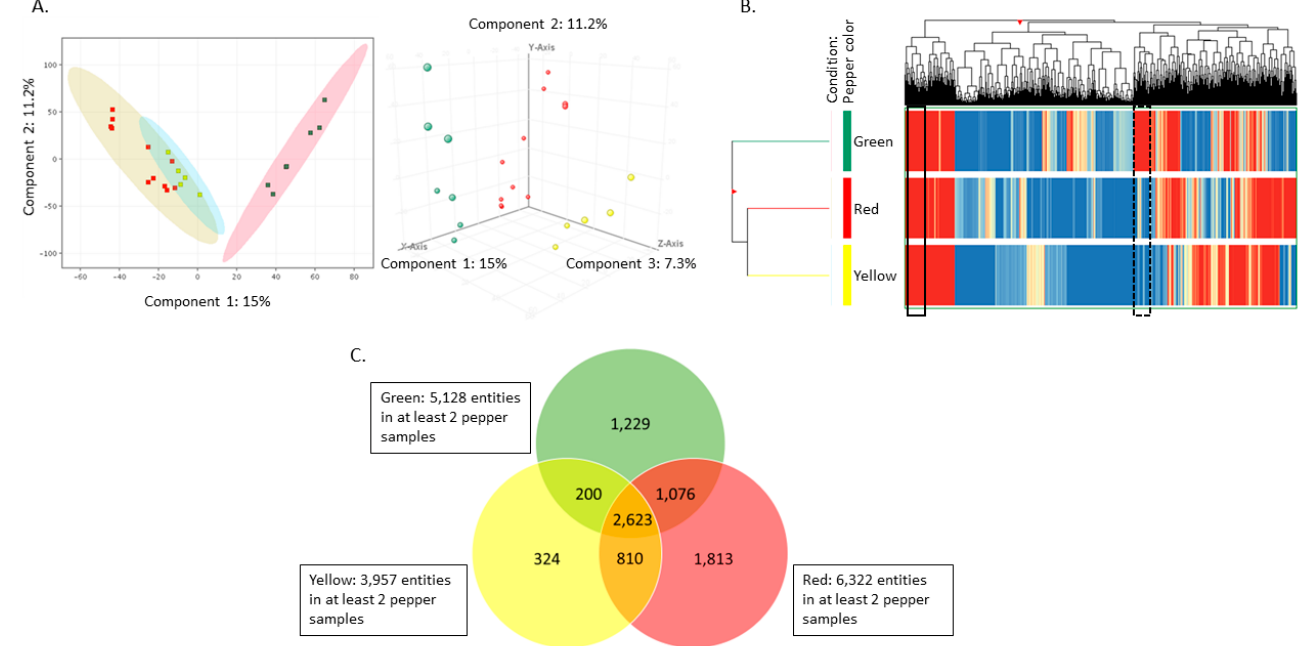
Figure 1. Pepper color is the main driver of differences between pepper conditions. ( A ) Principal component analysis (PCA) was performed in Agilent Technologies Mass Profiler Professional Version 14.1 (MPP) using data from all bell pepper samples. Component 1, which explains 15% of the variation, is shown on the x -axis; component 2, which explains 11.2% of the variation, is shown on the y -axis; and component 3, which explains 7.3% of the variation, is shown on the z -axis. ( B ) Hierarchical clustering of data from 23 replicates from six individual bell peppers. The x -axis corresponds to individual compounds detected in the peppers, which are grouped by color and listed on the y -axis. Blue lines indicate less relative abundance of a compound compared to the other 8174 compounds, while red lines indicate higher relative abundance compared to the other 8174 compounds. The vertical distance between compounds provides a rough estimation of their similarity. ( C ) Venn diagram illustrates overlap between the 2623 compounds detected in all colors of pepper samples (center section), the 1229 compounds detected in green peppers (green circle), but not red or yellow; the 200 compounds in both green and yellow; and the 1076 compounds in both green and red pepper. Within the yellow peppers (yellow circle), 324 compounds were detected in yellow but not red or green and 810 compounds were detected in both yellow and red bell peppers. Red peppers contained 1813 compounds that were detected in red (red circle), but not green or yellow bell